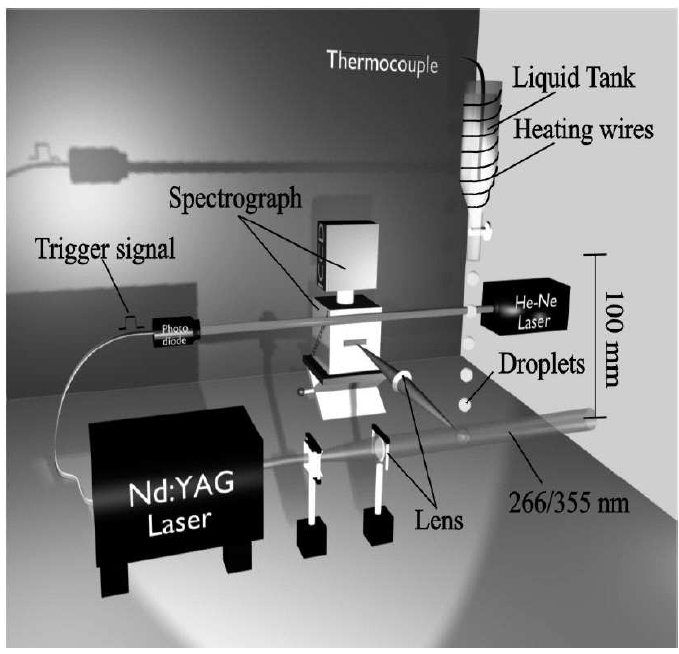
Figure 61 . Experimental set up for droplet temperature measurement using thermographic phosphors [86].